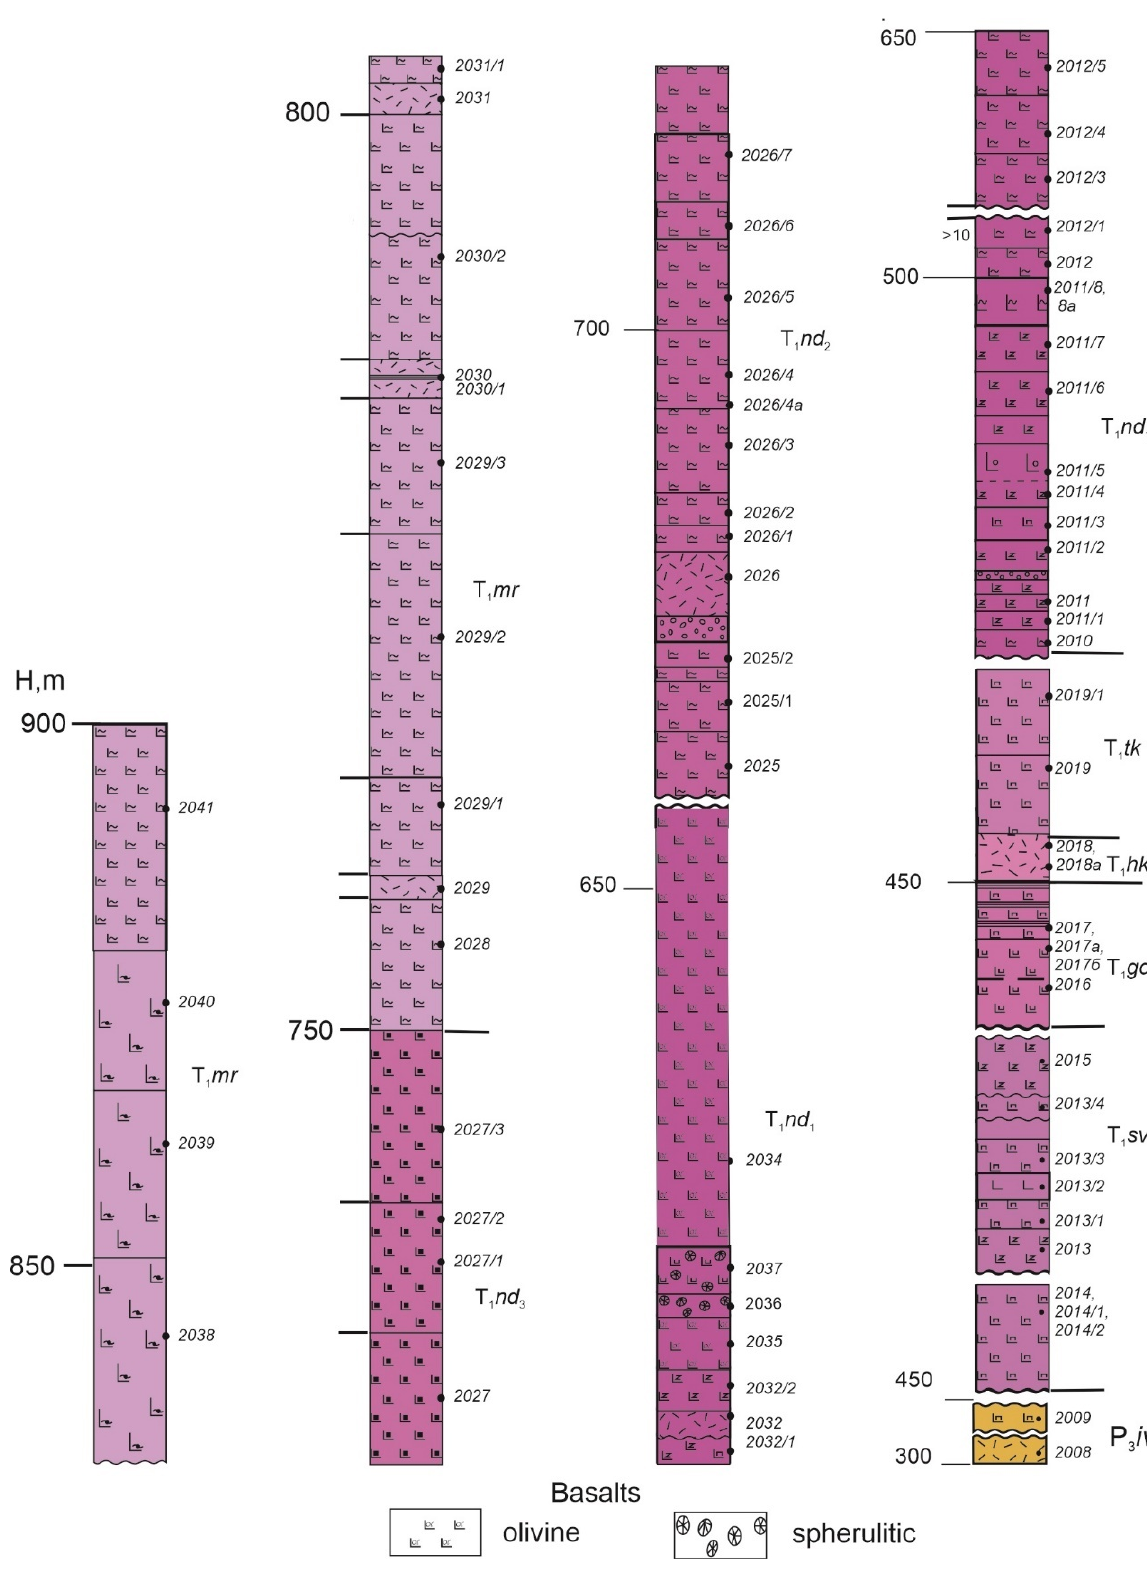
Figure 5. Volcanic section in the Khikey River valley, Captions in Figures 2 and 4. The rocks of the Gudchikhinsky Formation (T 1 gd ) are located stratigraphically above the basalts of the Syverminsky Formation and are separated from them by psammite tuff (0.5 m). The rocks of this Formation have a melanocratic appearance compared to the other Formations, due to the altered olivine. This Formation consists of three subformations in the Norilsk area [26,35] represented by olivine basalts, picrites, and glomeroporphyritic basalts, respectively. The rocks of the lower and upper subformations are absent in this section. Only the picrites and picritic basalts of the middle subformation occur. A total of